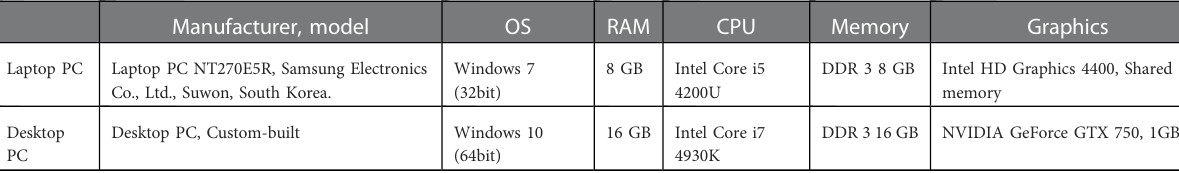
TABLE 1 Speci fi cations of the laptop and the desktop personal computers (PCs). Manufacturer, model